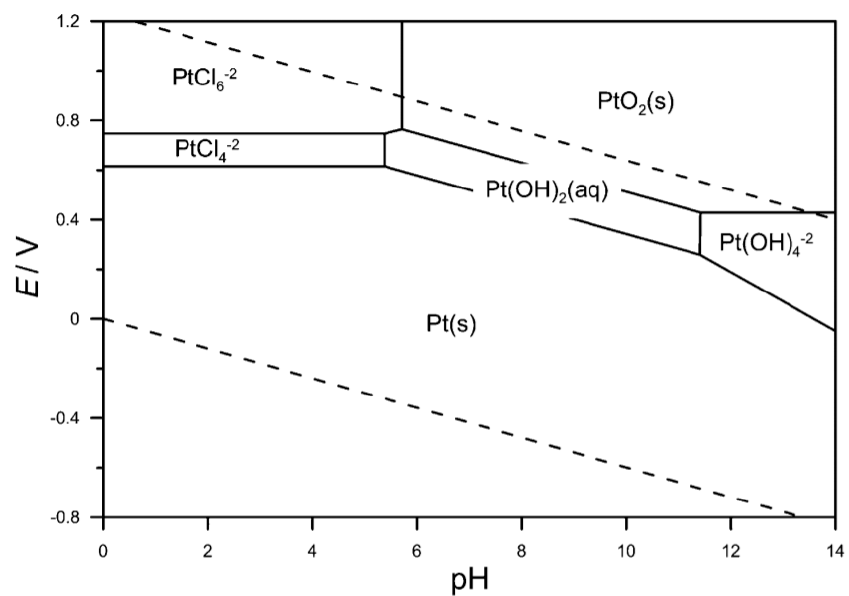
Figure 3. Pourbaix diagram. E vs pH in an electrolyte containing 0.5 M HCl. The solid lines demarcate the stability regions of varius Pt species, whereas the dashed lines separate the stability regions of water. From Ref. [82].